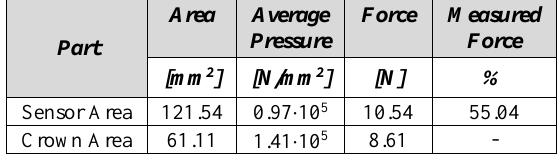
Table 3. Percentage of forces which is applied to the sensor when using the Deep3R8 sensor housing.